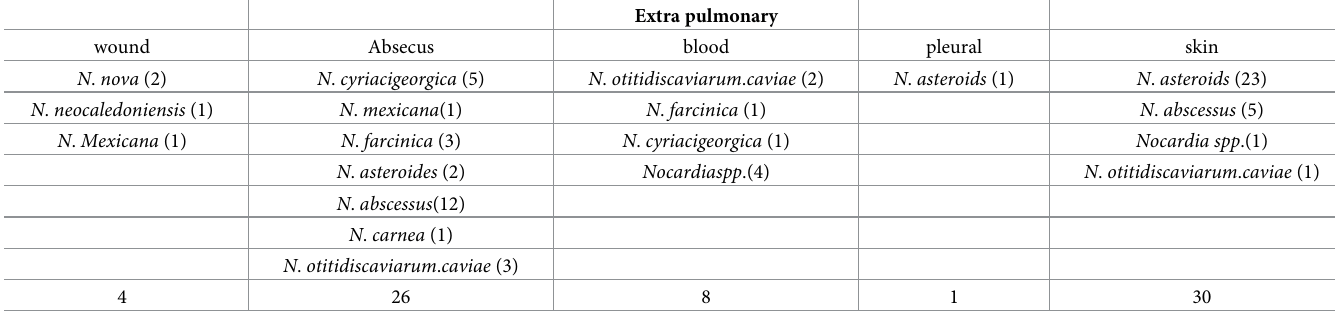
Table 5. The distribution of extrapulmonary Nocardiosis